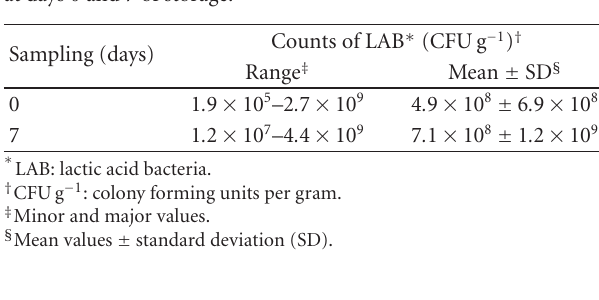
Table 3: Lactic acid bacteria counts (CFUg − 1 ) from brewer’s grain at days 0 and 7 of storage.